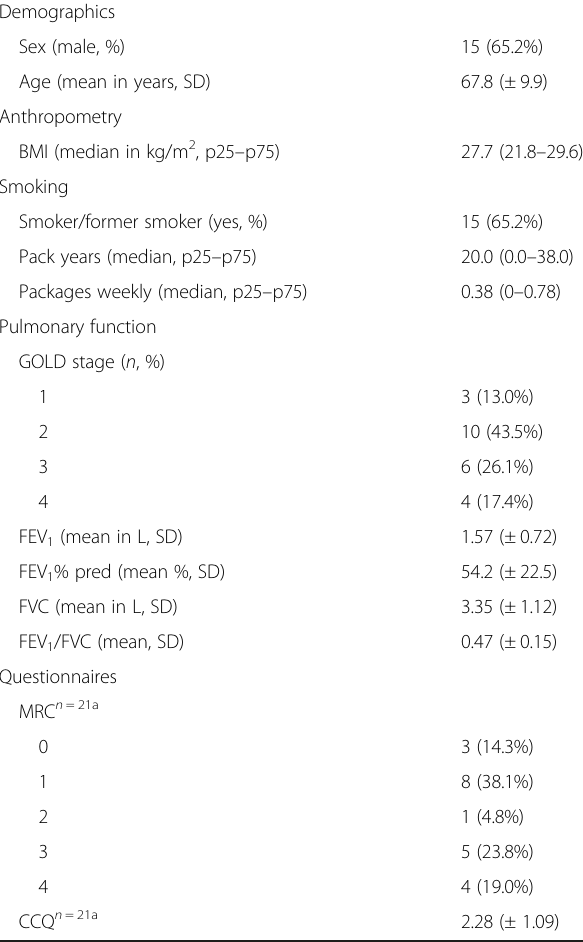
Table 1 Characteristics and demographics of the